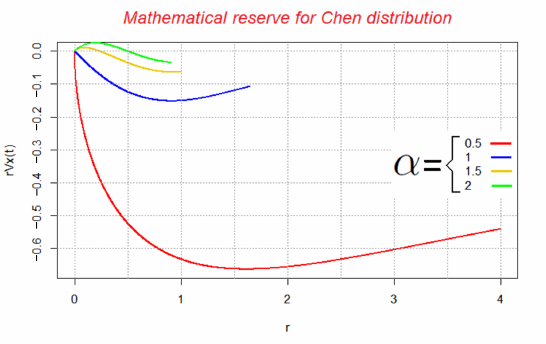
Figure 4. Mathematical reserve t ¯ V ( x ( 0 )) , for Chen distribution with parameters θ = 1 and α = 0.5,